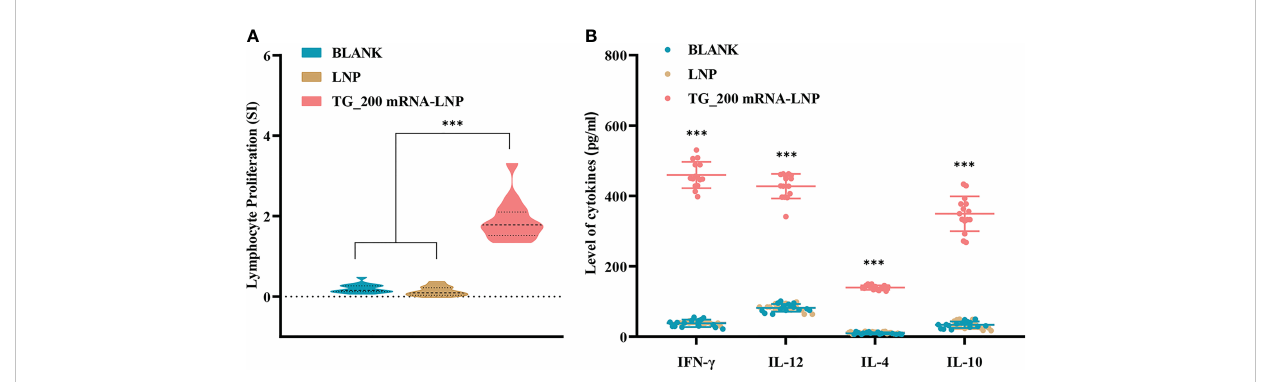
FIGURE 5 Splenocyte proliferation and cytokine production levels after TG_200 mRNA-LNP immunization. (A) Proliferative responses of splenocytes of BALB/c mice immunized with LNP, TG_200 mRNA-LNP, or the BLANK control, n = 5/group, *** P < 0.001. (B) Cytokine production by splenocytes of mice immunized with LNP, TG_200 mRNA-LNP, or the BLANK control. The vertical axis is the cytokine concentration (pg/mL). The horizontal axis shows IFN- g , IL-12, IL-4, and IL-10, n = 5/group, *** P < 0.001. Data are shown as the means ± SD of three independent